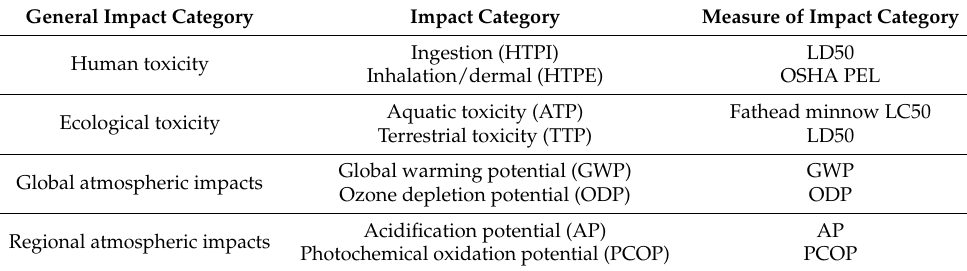
Table 2. Impact categories that constitute the basis of the potential environmental impact [86,88].